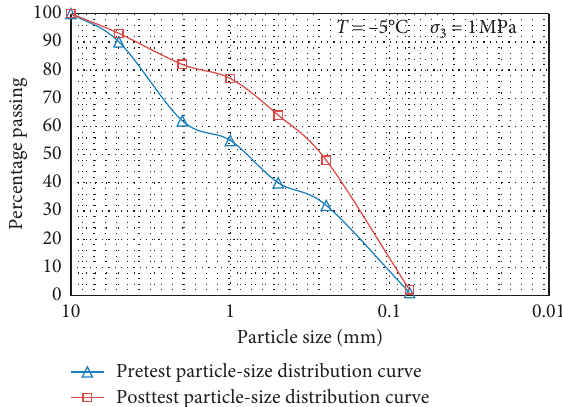
Figure 1: Particle-size distribution curves before and after triaxial compression tests.